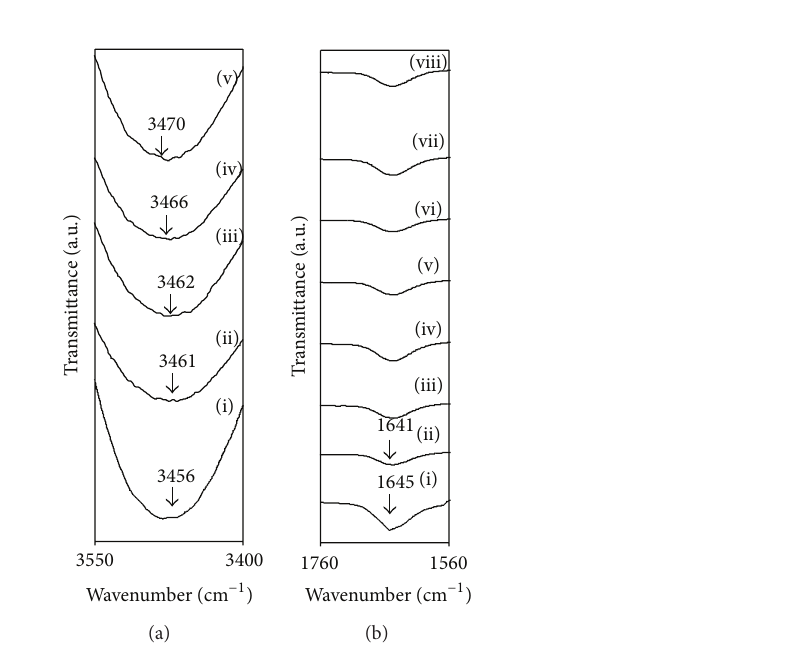
Figure 5: (a) FTIR spectra of (i) 90 wt.% PEO-10wt.% GO-25 wt.% LiCF 3 SO 3 film with (ii) 0.2wt.% ES, (iii) 0.4 wt.% ES, (iv) 1.0wt.% ES,